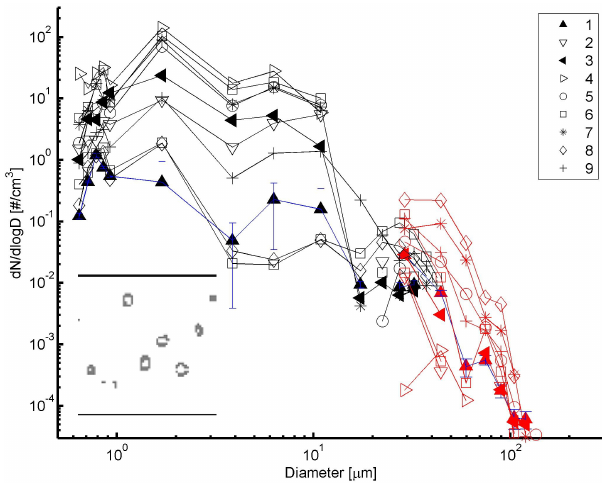
Fig. 3. Average particle size distribution d N /dlog D p [#/cm 3 /µm vs. maximum size in µm] recorded over each verified orbit contrail pass during Flight B587 (pass number identified by the legend, cf. Ta- ble 1), for the CAS (black) and CIP-GS (red) probe. Error bars of one standard deviation are shown for pass 1, error bars are much larger for those passes featuring concentrations > 50cm − 3 (see Ta- ble 1). CIP-GS images are shown from Pass